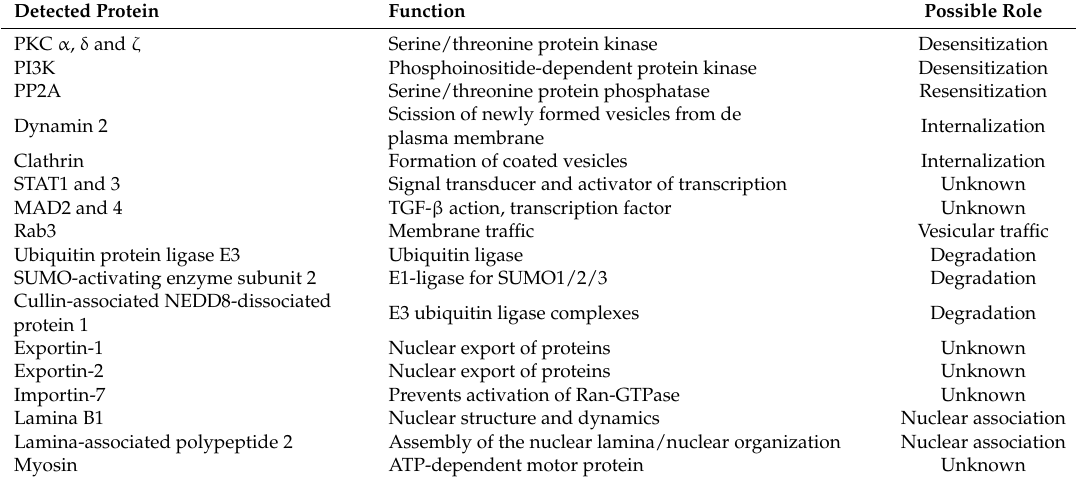
Table 3. Protein detected MS of immunopurified α 1A -adrenoceptors. PKC, protein kinase C; PI3K, phosphoinositide 3-kinase; PP2A, protein phosphatase 2A; STAT, signal transducer and activator of